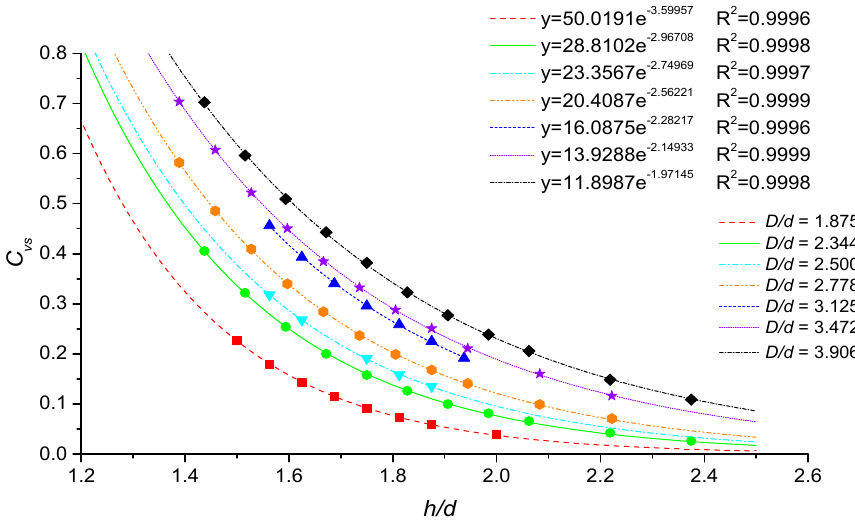
Figure 10. Relations between vertical suction force coefficients and ratios of h to d .